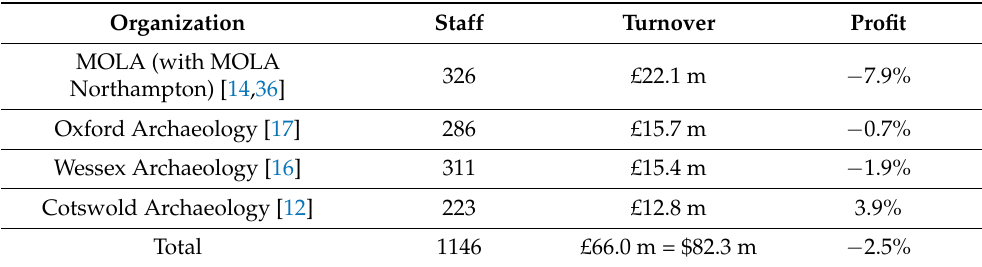
Table 3. 2019–2020 financial figures for four archaeological